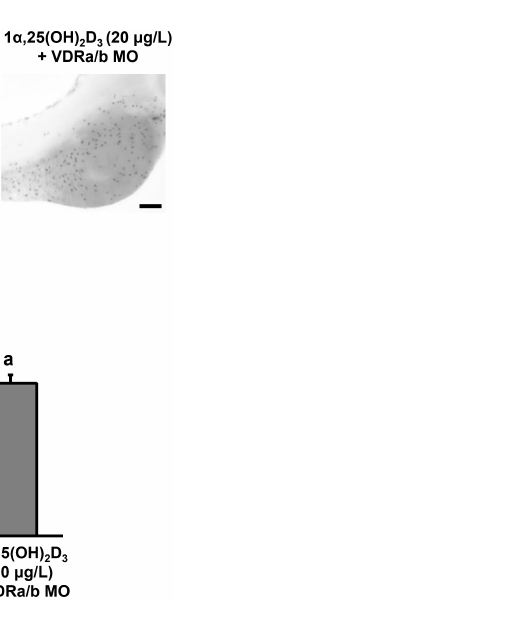
FIGURE 6 The effect of VDR MOs on the density of foxi3a -expressing cell in 3 dpf zebra fi sh larvae treated with 1 a ,25(OH) 2 D 3 . (A) The representative images of whole mount in situ hybridization showing the expression of foxi3a -expressing cell (black dots) in the yolk sac of zebra fi sh larvae treated with 0 (control) and 20 m g/L 1 a ,25(OH) 2 D 3 . (B) The quantitative data for the cell density. Different letters indicate a signi fi cant difference (p<0.05), as determined using one-way ANOVA followed by Tukey ’ s multiple-comparison test. Values are the mean ± SEM ( n =9). Scale bar: 100 m